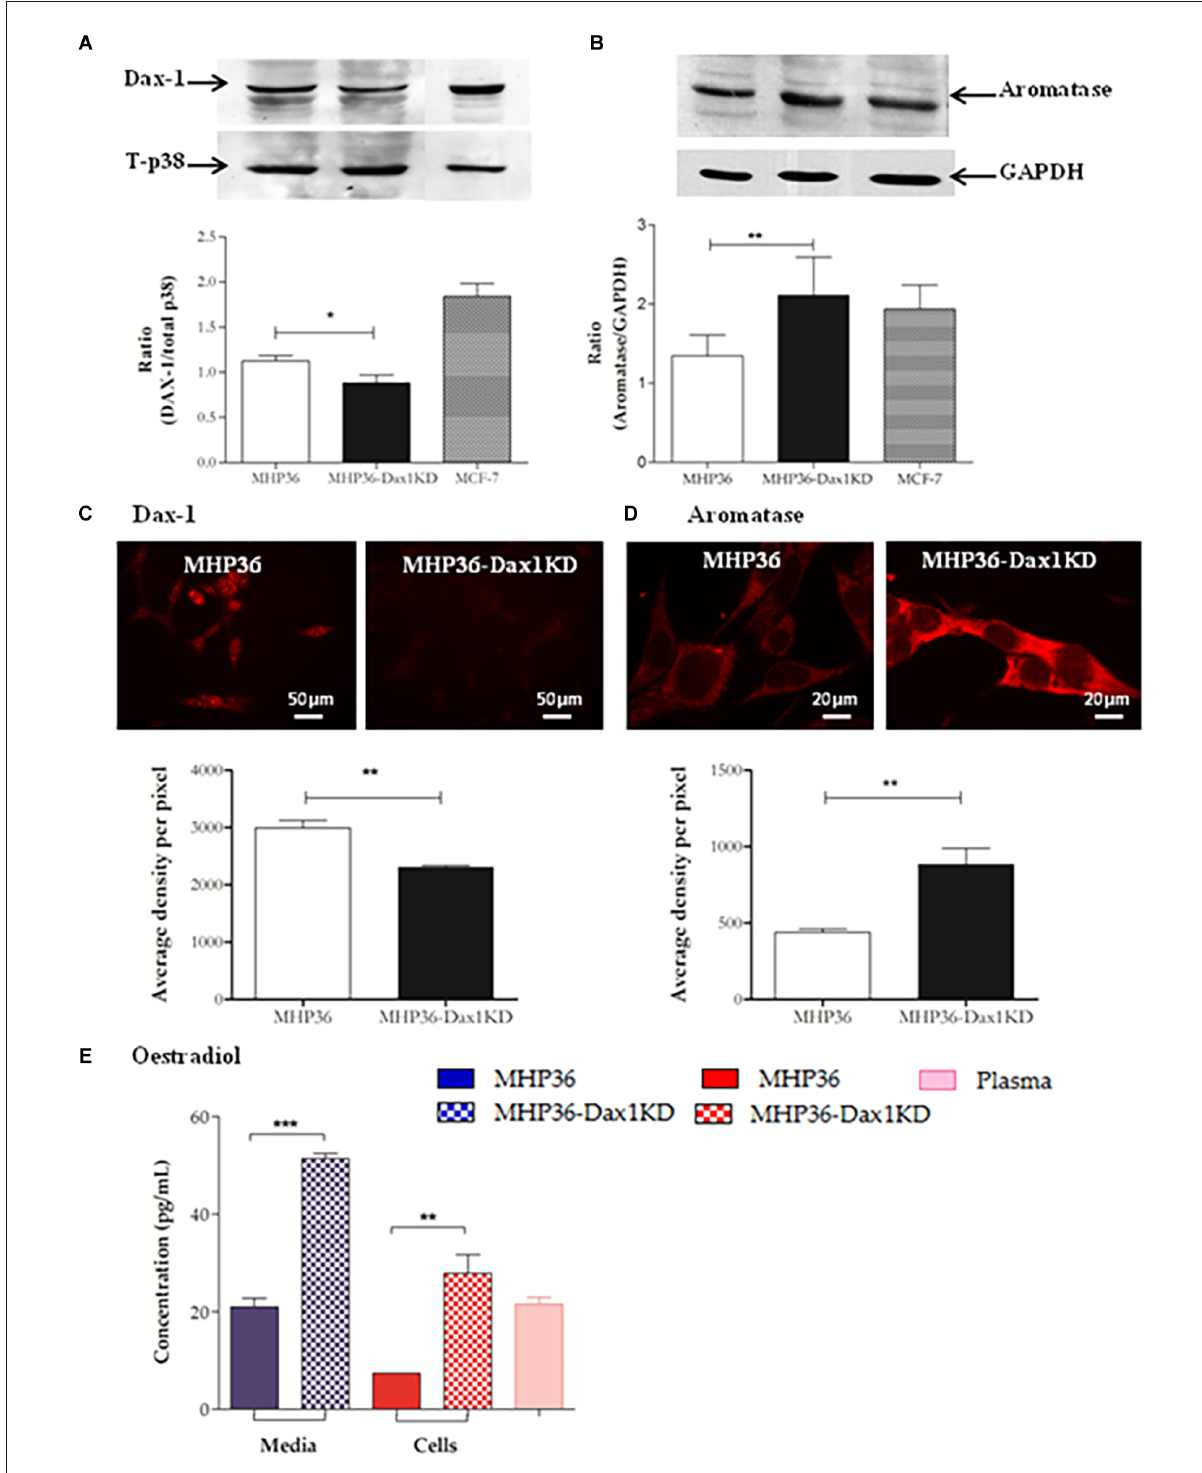
FIGURE1 Characterization of MHP36-Dax1KD for 17 β -estradiol. Knockdown of expression of Dax-1 and overexpression of aromatase in MHP36-Dax1KD when compared to MHP36 cells using (A,B) Western blotting (graphical representation expressed as a ratio over total p38 or GAPDH) and (C,D) immunofluorescence (graphical representation expressed as mean intensity per pixel of protein of interest). (E) Levels of 17 β -estradiol released into the media and produced by MHP36 and MHP36-Dax1KD cells using ELISA with plasma (female 129svJ mouse) as a positive control to show alignment with physiological levels ( ∗ p < 0.05, ∗∗ p < 0.01, ∗∗∗ p < 0.001, unpaired t -test, n =